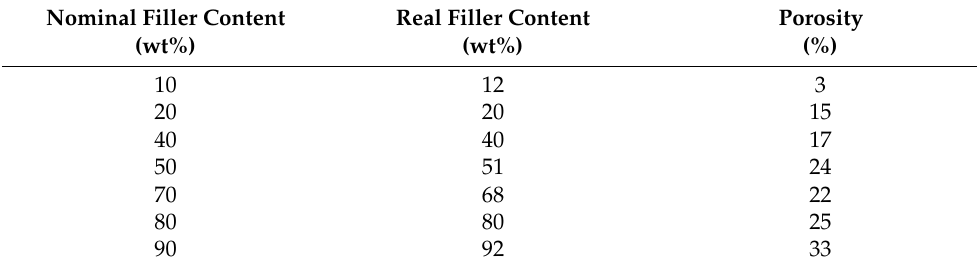
Table 2. Porosity of compact samples (i, ii) at different filler